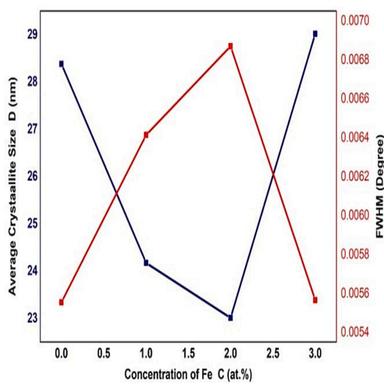
Relation between FWHM, average crystalline size and concentration of Fe doping.